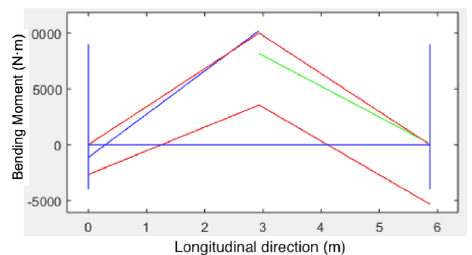
Figure 8. Bending moments for a concentrated load of 6000N at mid span. Blue and green lines correspond to bending moments, upper red line represents diagram for a pin-supported beam, lower red line represents diagram for a fixed-supported beam, and both cases are obtained from beam mechanics theory, solving problem assuming exact values for loads. It is difficult to obtain the error because supports rigidity were not assessed precisely (as it was considered a not influential input parameter) and therefore theoretic value is unknown. However, we can predict that bending moment at each section will be covered between pin and fixed-supported